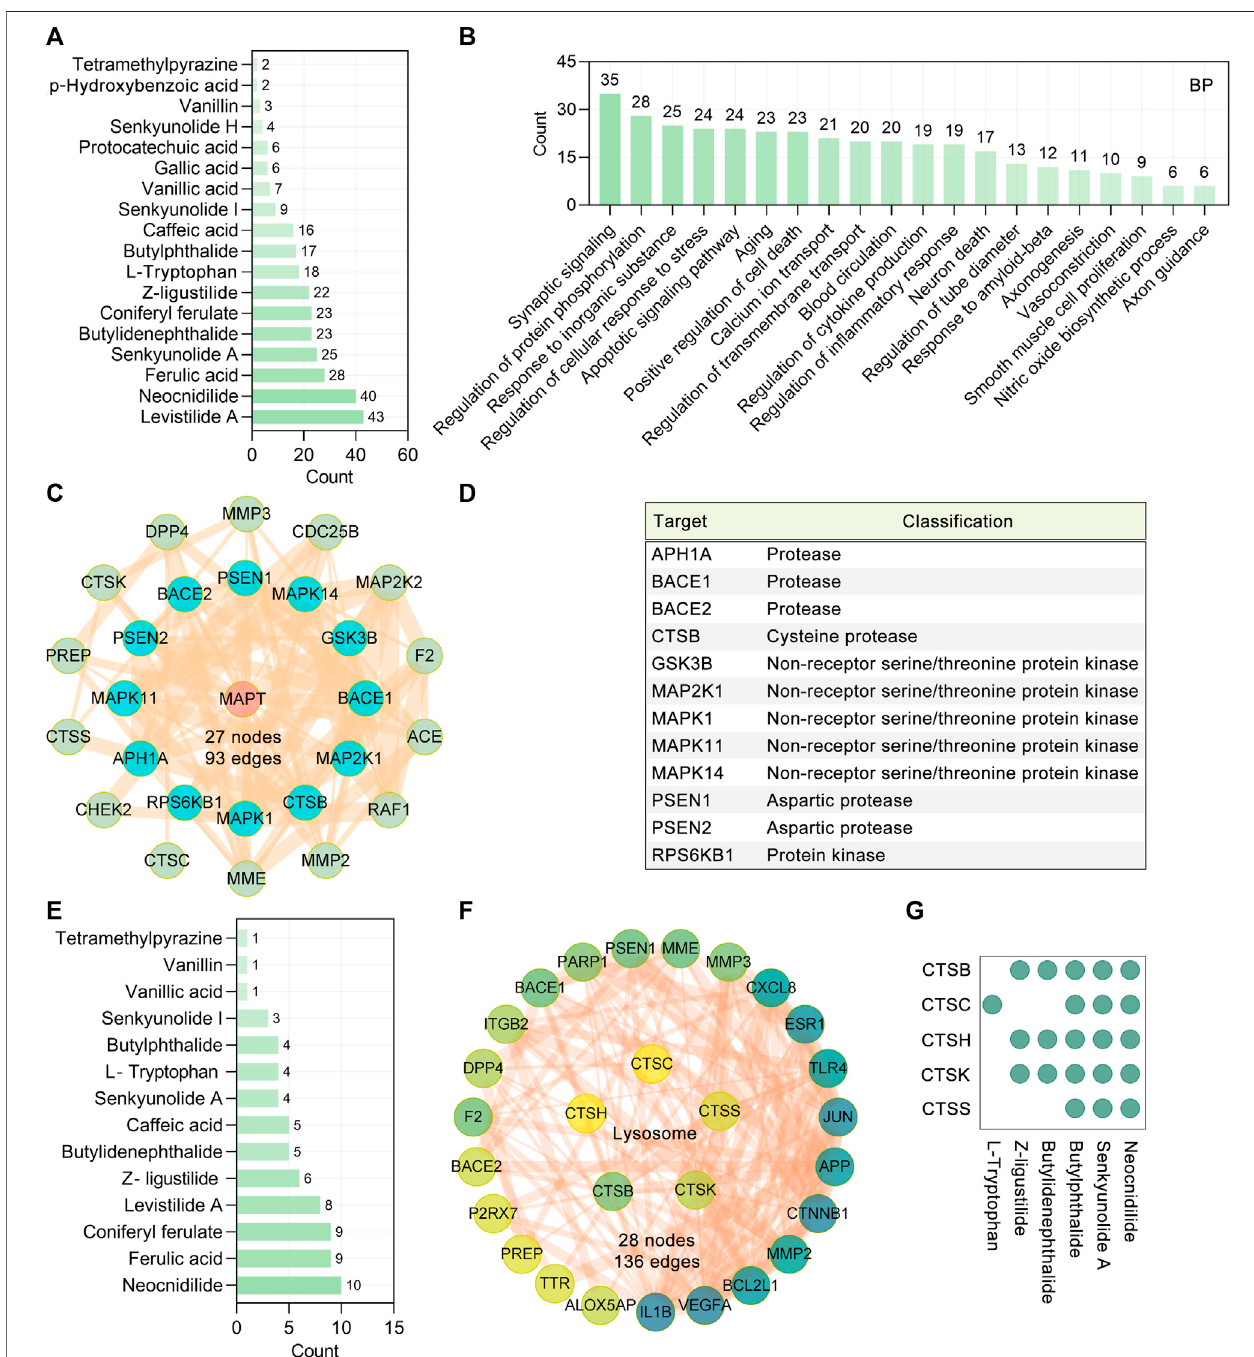
FIGURE3| CR targets related totauaggregation. (A) 18 mainbioactive phytochemicalsofCR and thenumbers oftheirtargetsassociated withtau pathogenesis. Thebar diagramdisplays thenumbersoftaupathogenesis – related targets targeted bythephytochemicals. (B) GObiologicalprocessanalysisofCRtargetsassociated with tau pathogenesis. BP terms with a p value < 0.05 were considered signi fi cant. The bar diagram displaying the numbers of tau pathogenesis – related targets of CR enriched in the different biological processes. (C) The PPI network showing the CR targets associated with the modi fi cation of tau (encoded by MAPT). Red circle node: MAPT. Cyan and green nodes represent protein modi fi cation enzymes directly or indirectly acting on MAPT, respectively. (D) Classi fi cation of protein modifying enzymes directly acting on tau protein. (E) CR phytochemicals involved in tau modi fi cation ranked according to the numbers of targets. (F) PPI network of CR targets associated with the lysosome pathway (hsa04142). The color of the node correlated with its degree value. (G) CR phytochemicals corresponding to targets involved in the lysosome pathway.